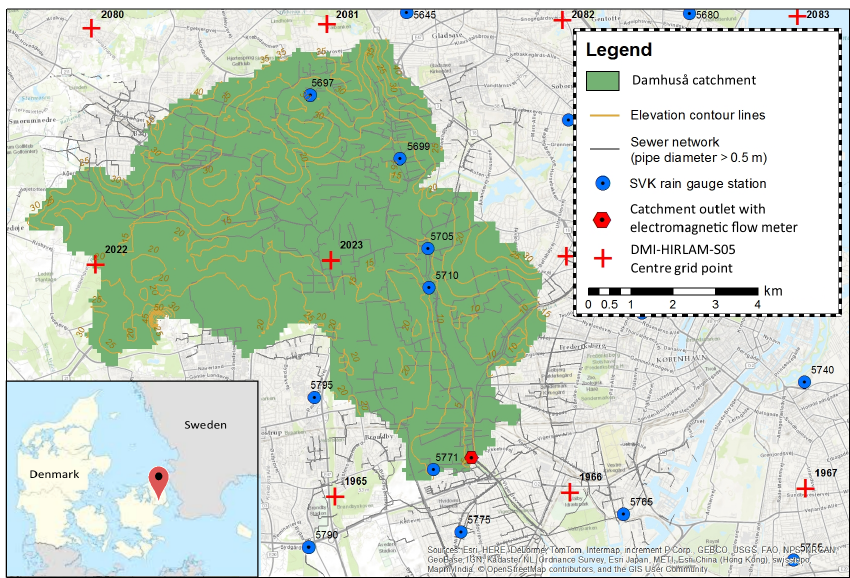
Figure 3. The Damhuså urban drainage catchment, Copenhagen, Denmark (contributing area: green area on the map).